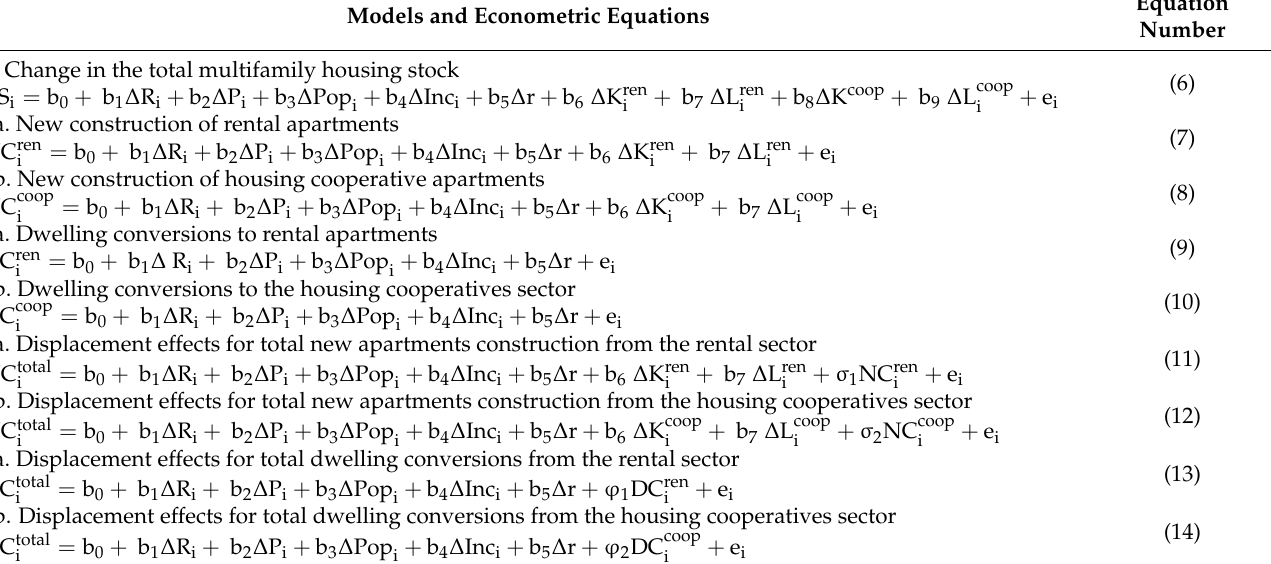
Table 1. Econometric